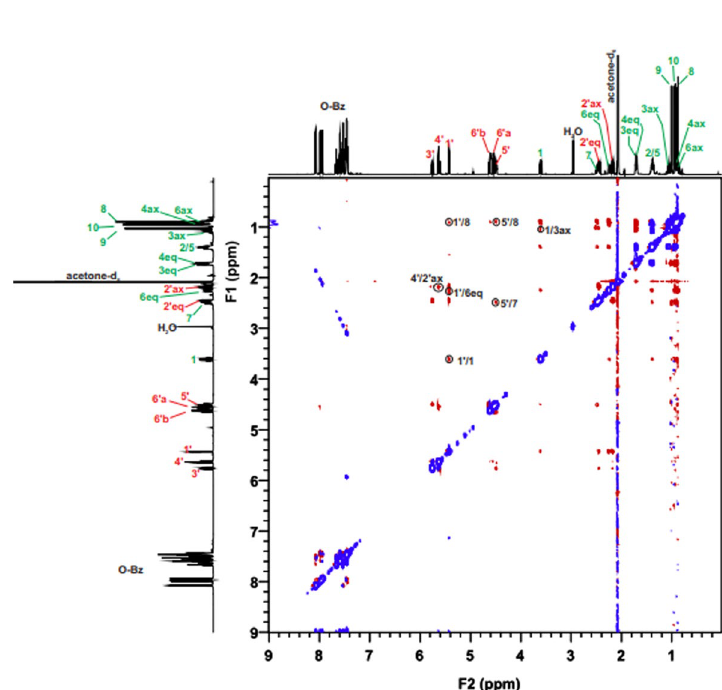
Figure 7. ROESY spectrum of molecule 1 A with all dipole couplings (diagnostic signals are marked in a